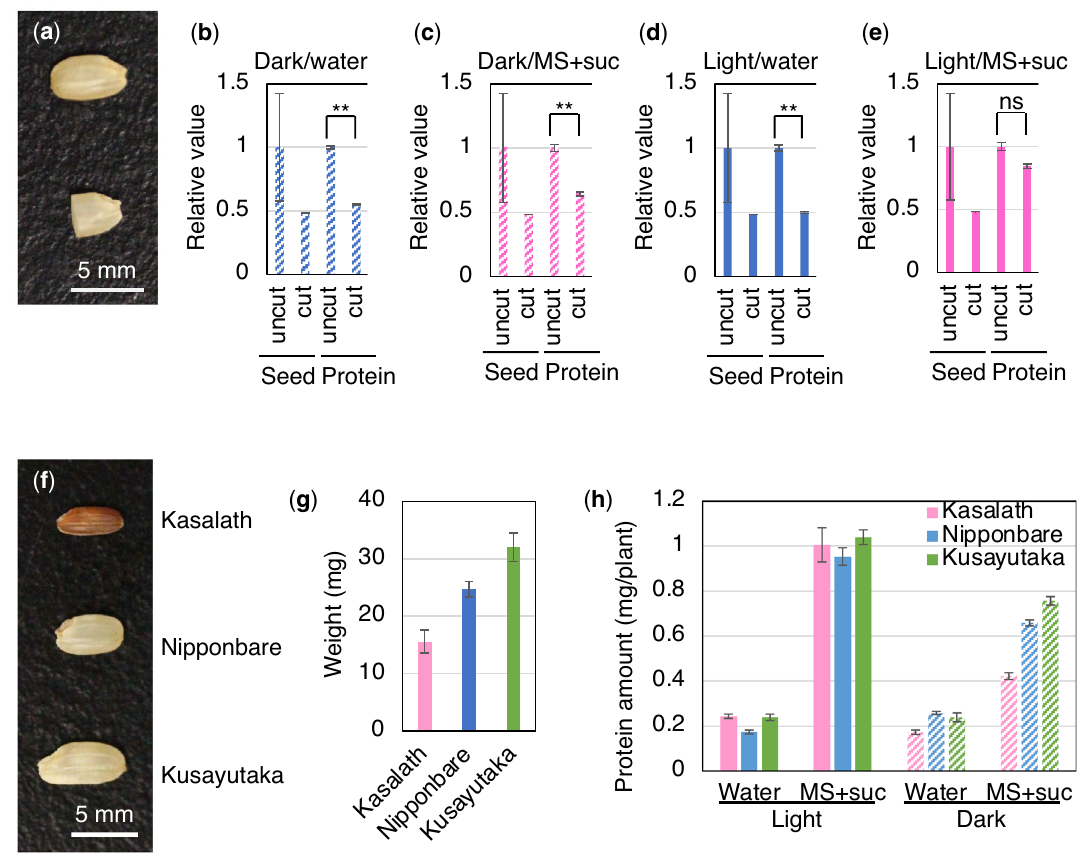
Figure 7. Effect of seed size on the protein amount produced in rice seedlings. ( a ) Representative picture of Nipponbare uncut and cut seeds. ( b – e ) Protein amount of Nipponbare seedlings germinated from uncut and cut seeds in darkness with water ( b ) and MS medium and 30 g/l sucrose ( c ), or in light with water ( d ) and MS medium and 30 g/l sucrose ( e ). Relative weight (n = 40) or protein amount (n = 5) is shown. The value of uncut seeds was set as 1. Left two bars show seed weight, and right two bars show the protein amount. **Significant difference by Student’s t test ( P < 0.01). ns: not significant ( P > 0.05). ( f ) Representative picture of Kasalath, Nipponbare and Kusayutaka seeds. ( g ) Weight of Kasalath, Nipponbare and Kusayutaka seeds. The three cultivars showed significant difference by ANOVA at P < 0.05. ( h ) Total protein amount in Kasalath, Nipponbare and Kusayutaka seedlings. Seeds were germinated in light or in darkness with or without supplementation of MS medium and 30 g/l sucrose. Total soluble protein of each seedling (n = 5) was extracted at 11 DAG. No significant difference was observed between the three cultivars except between Kasalath and the other two cultivars in the condition with supplementation of MS medium and 30 g/l sucrose in darkness by ANOVA at P <